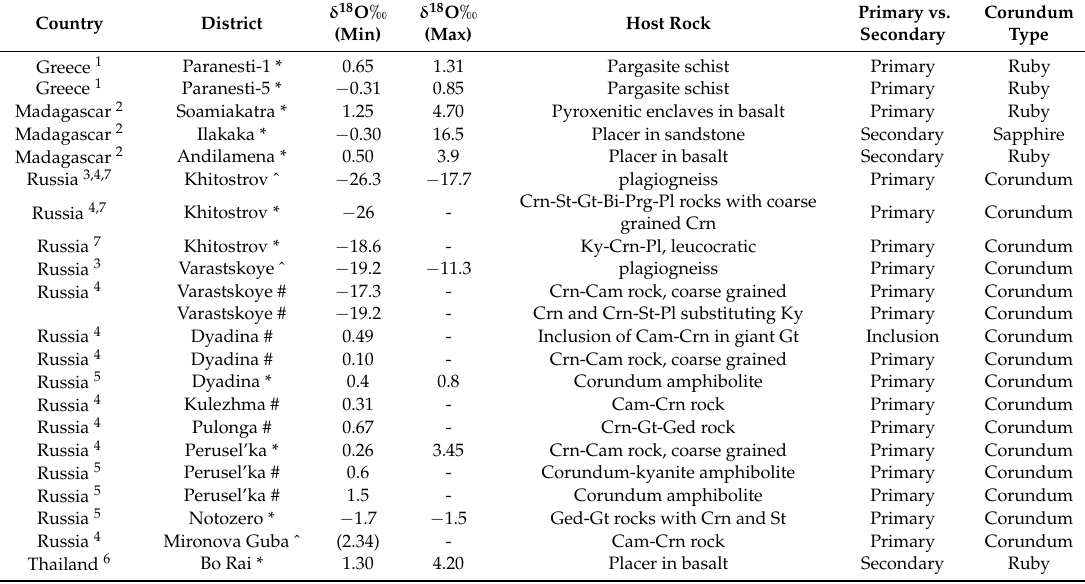
Table 4. Global comparison of corundums with low oxygen isotope values.